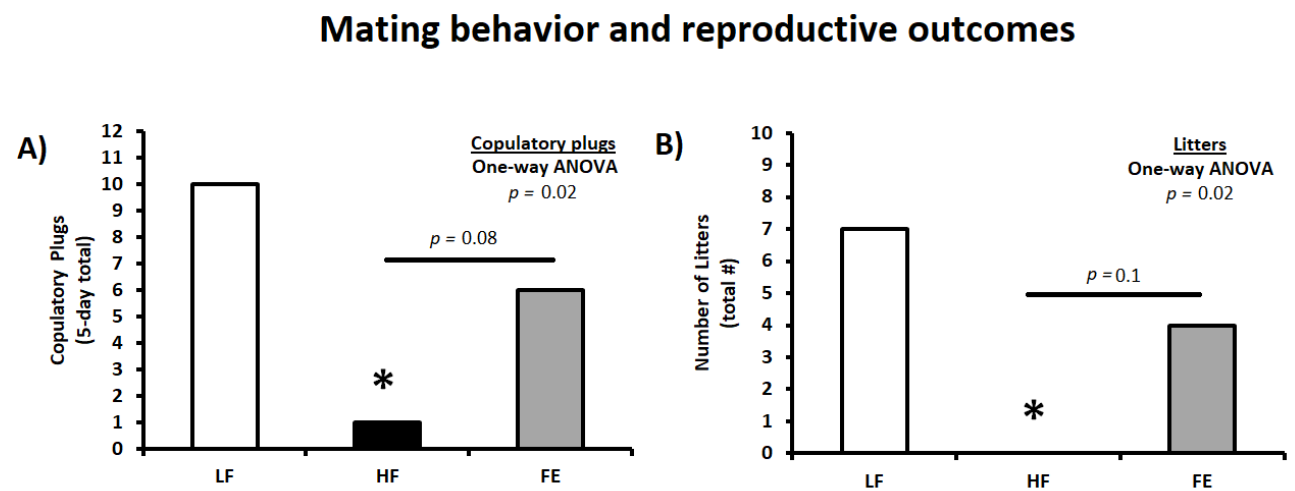
Figure 8. Effects of the ‘Fertility Enhancer’ supplement on mating behavior and reproductive outcomes in Western diet-fed C57BL/6J mice. ( A ) Five-day total copulatory plugs in females. ( B ) Total number of litters. LF = Low Fat Diet, HF = Western Diet (WD), and FE = ‘Fertility Enhancer’ multi- nutrient supplement with WD. * Significantly different from LF ( p ≤ 0.05). Table 2. Effect of multi-nutrient supplementation on mating behavior and reproductive outcomes in Western diet-fed C57BL/6J mice.